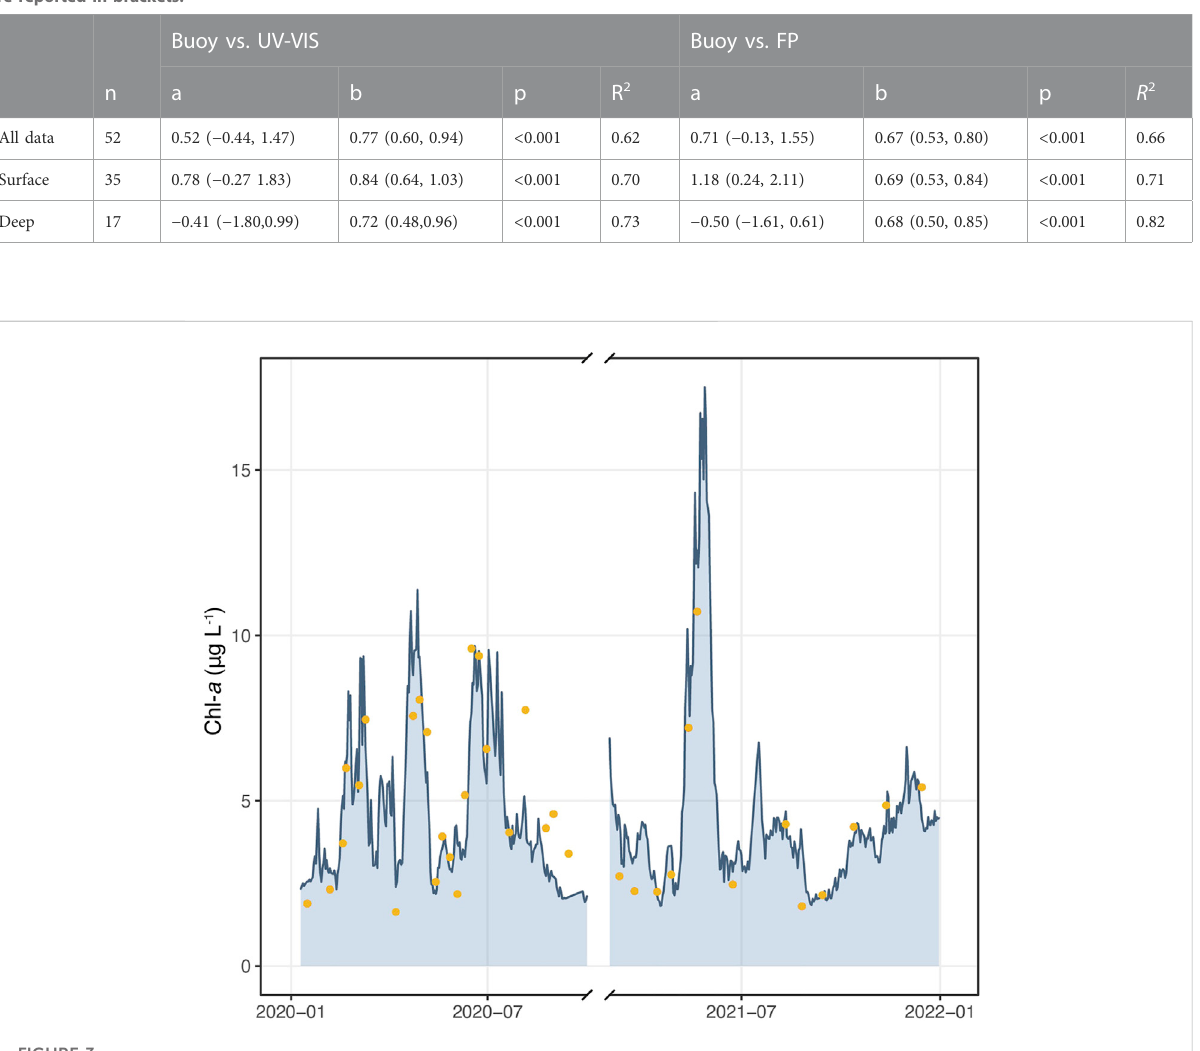
FIGURE 3 Hourly average data of Chl- a concentrations from in-situ sensors (bluish area) and Chl- a concentrations in the surface samples collected in 2020 – 21 and analysed by UV-VIS spectrophotometry (yellow